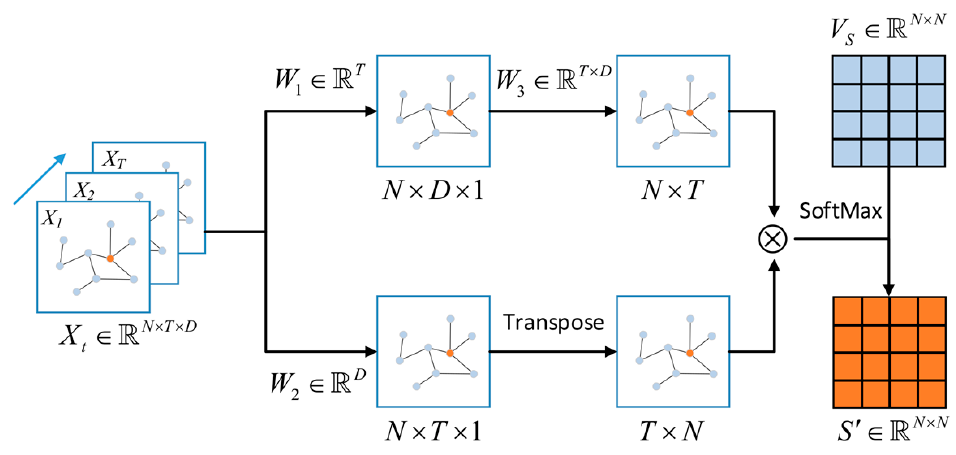
Figure 5. Spatial attention Figure 5. Spatial a tt ention mechanism.